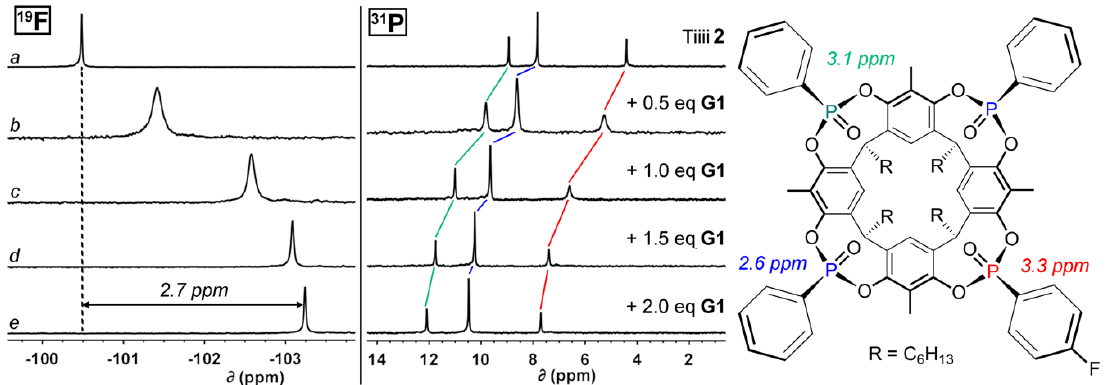
Figure 2. 19 F (376 MHz, CDCl 3 , 298 K) and 31 P NMR (162 MHz, CDCl 3 , 298 K) spectra of free host 2 ( a ), 2 + 0.5 eq. of G1 ( b ), 2 + 1.0 eq. of G1 ( c ), 2 + 1.5 eq. of G1 ( d ), 2 + 2.0 eq. of G1 ( e ); on the right chemical shift variations for the three phosphorus signals are reported.